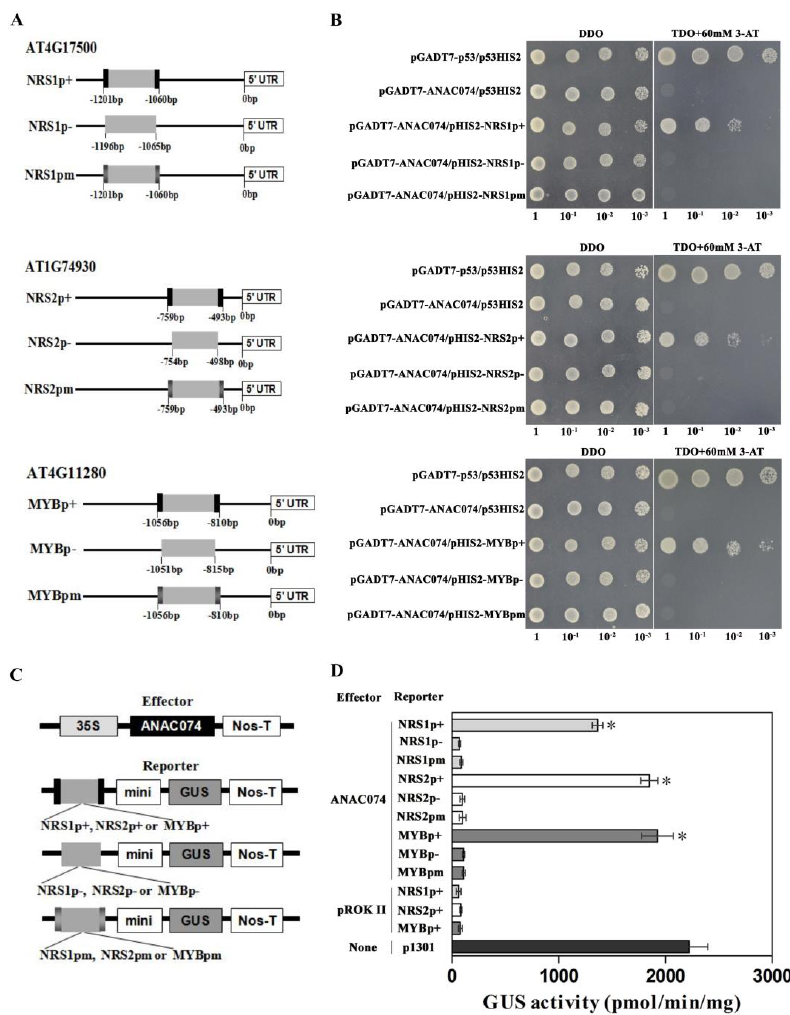
Figure 3. ANAC074 can bind the promoter of AT4G17500 , AT1G74930, and AT4G11280 via the NRS1, NRS2 or MybSt1 element. ( A ) Schematic diagram of the truncated promoters containing NRS1, NRS2, or MybSt1, without NRS1, NRS2, or MybSt1, or with the mutated NRS1, NRS2, or MybSt1 used in Y1H analysis. NRS1p+, NRS2p+, MYBp+: the truncated promoter with NRS1, NRS2, or MybSt1. NRS1p-, NRS2p-, MYBp-: the truncated promoter without NRS1, NRS2, or MybSt1. NRS1pm, NRS2pm, MYBpm: the truncated promoter with the completely mutated NRS1, NRS2, or MybSt1. Black shading indicates NRS1, NRS2, or MybSt1 motif. Dark grey shading indicates completely mutated NRS1, NRS2, or MybSt1 motif. ( B ) Analyses of the binding of ANAC074 to the truncated promoters containing NRS1, NRS2, or MybSt1 motif using Y1H. Positive transformants were further identified by spotting yeast cells with serial dilutions (1/1, 1/10, 1/100, 1/1000) onto medium of SD/-His/-Leu/-Trp with 60 mM 3-AT. The transformants grown at SD/-Leu/-Trp were as positive controls for transformant growth. Positive control: pGADT7-p53 interacting with p53HIS2; Negative control: pGADT7-ANAC074 interacting with p53HIS2. ( C ) Schematic diagram of the effector and reporter constructs used in vivo transient expression assays. ( D ) Analyses of the bindings of ANAC074 to the truncated promoters containing NRS1, NRS2, or MybSt1 motif used in the coexpression experiments. The different combinations between effector and reporter are shown in the left panel. The empty pCAMBIA1301 was as positive control. Co-transformations of empty pROKII with pCAM-NRS1p+, pCAM-NRS2p+ or pCAM-MYBp+ were as negative controls. Data represent mean values of three independent experiments, and bars indicate standard deviation (SD). Asterisks indicate a significant difference compared with NRS1p-, NRS2p-, or MYBp- (Student’s test; * p <